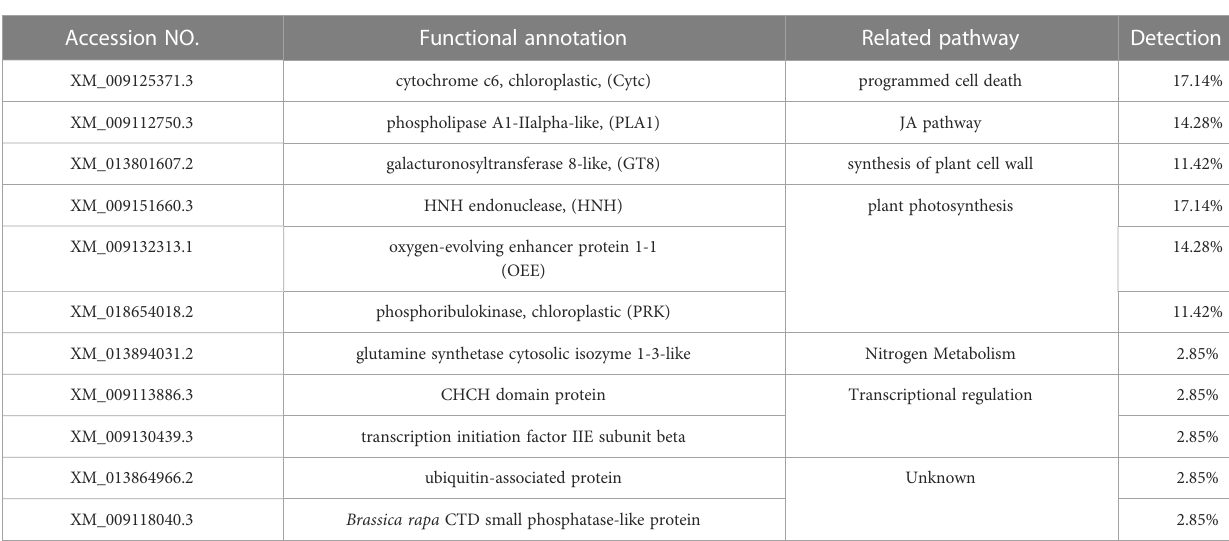
TABLE 3 Sequencing analysis of positive